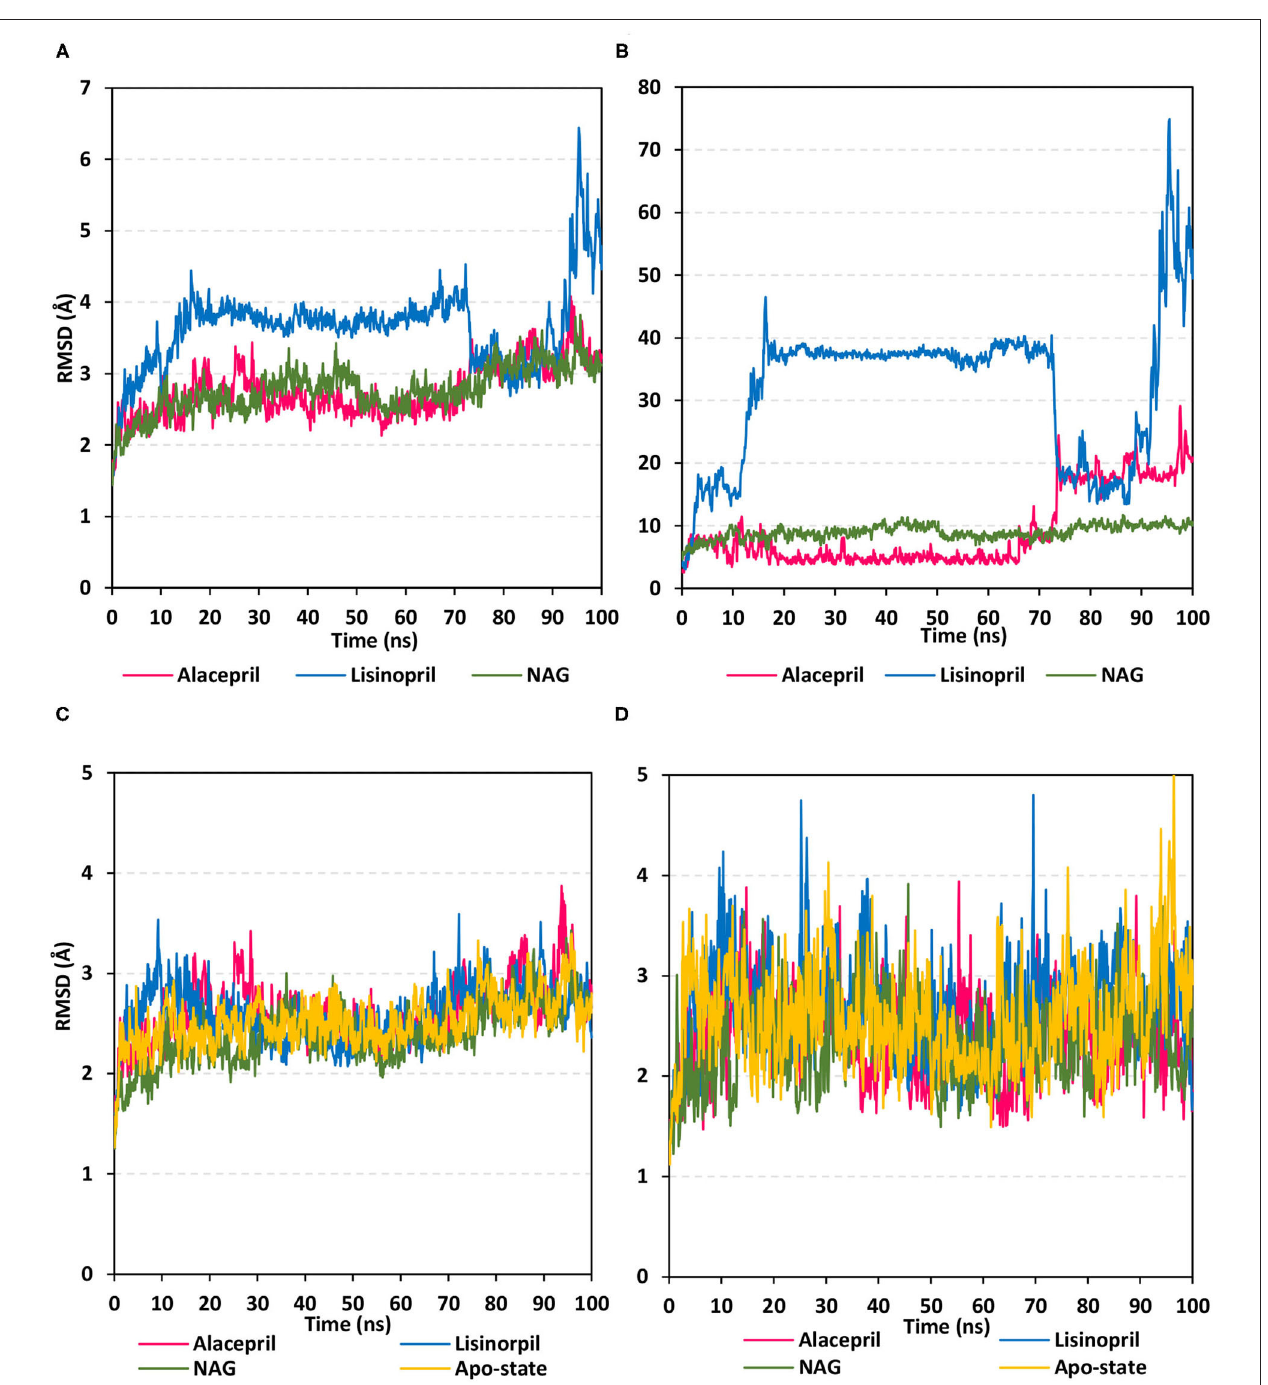
FIGURE 4 | Analysis of RMSD trajectories for the ligand- h ACE2 protein complexes throughout 100 ns all-atom MD simulation. (A) Complex RMSD; (B) ligand RMSD; (C) protein RMSD; (D) binding pocket residues RMSD, relative to backbone vs. MD simulation time in nanoseconds. Alacepril/ h ACE2 and lisinopril/ h ACE2 complexes as well as glycosylated (NAG)-bound and apo-state (all glycans being removed) h ACE2 proteins are illustrated in pink, blue, green, and yellow colors, respectively.